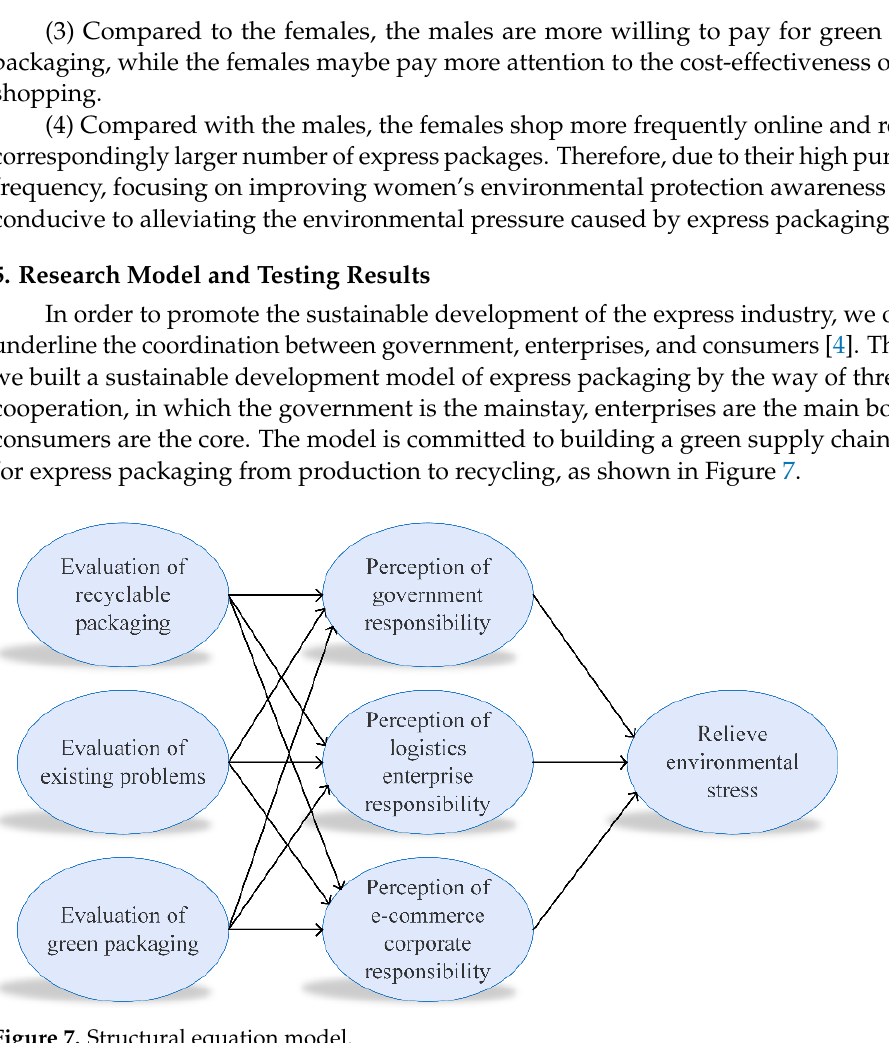
Figure 7. Structural equation model.